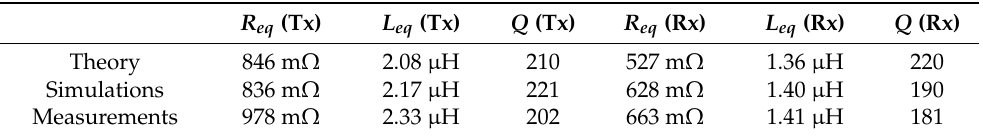
Table 4. Comparative table of theoretical results, simulations, and measurements of the electrical parameters and quality factor at 13.56